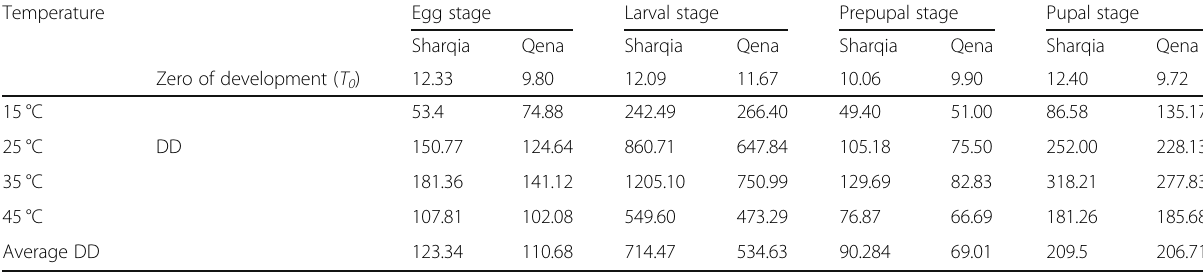
Table 1 Thermal requirements for treated O. nubilalis two strains from two different localities Temperature Egg stage Larval stage Prepupal